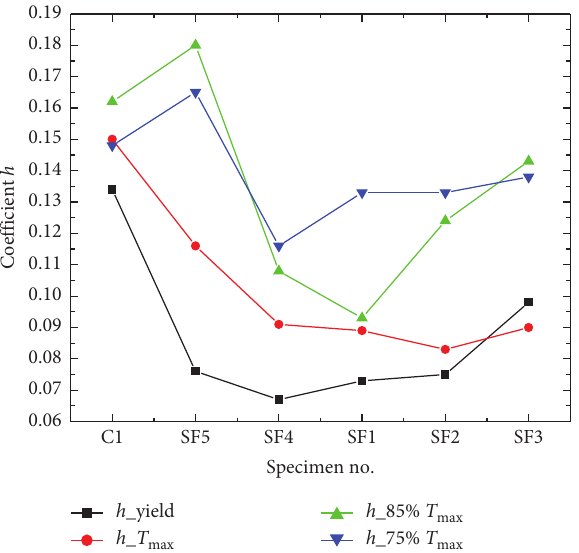
Figure 19: Coefficient h at different loading